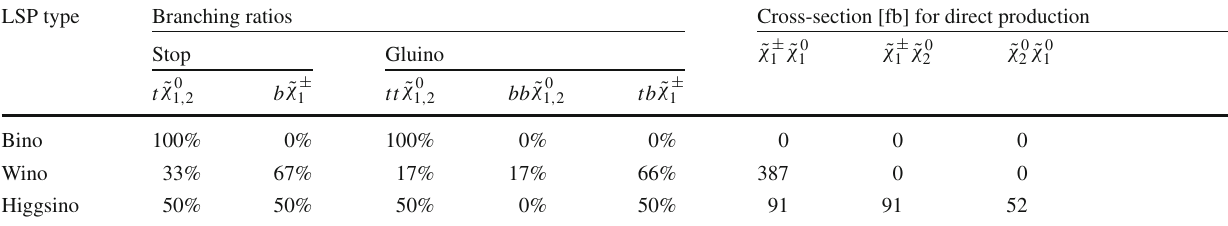
Table 1 Stop and gluino branching ratios, as well as cross-sections for direct electroweakino production, as a function of the LSP type. For a pure bino/wino/higgsino LSP, the electroweakino states considered